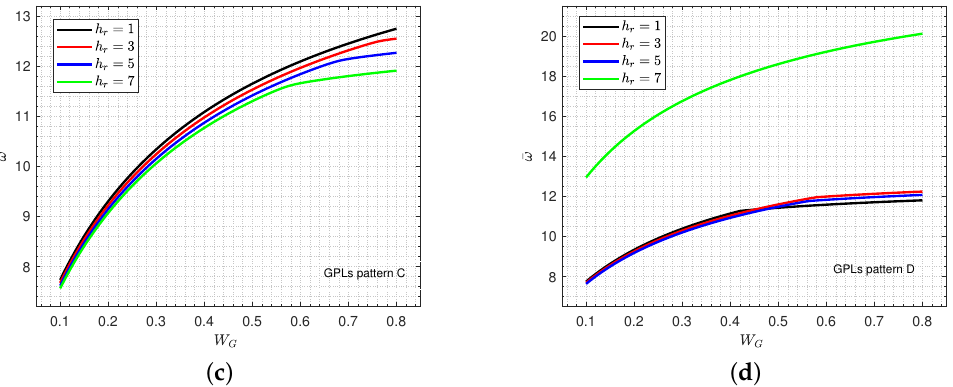
Figure 7. Influences of the graphene weight fraction W G and core-to-face thickness ratio h r on the wave frequency ¯ ω (THz) of the FG GPLs-reinforced sandwich nanocomposite piezoelectromagnetic plate with a honeycomb core for various patterns of GPLs distribution: ( a ) pattern A, ( b ) pattern B, ( c ) pattern C and ( d ) pattern D.